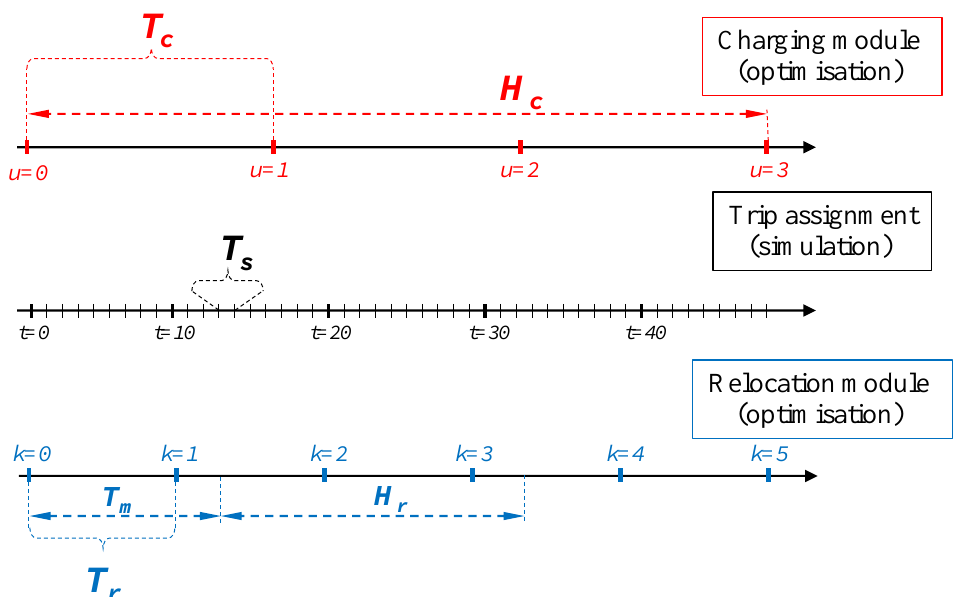
Figure 1. An outline of the timeline for the integrated simulation and optimisation framework.